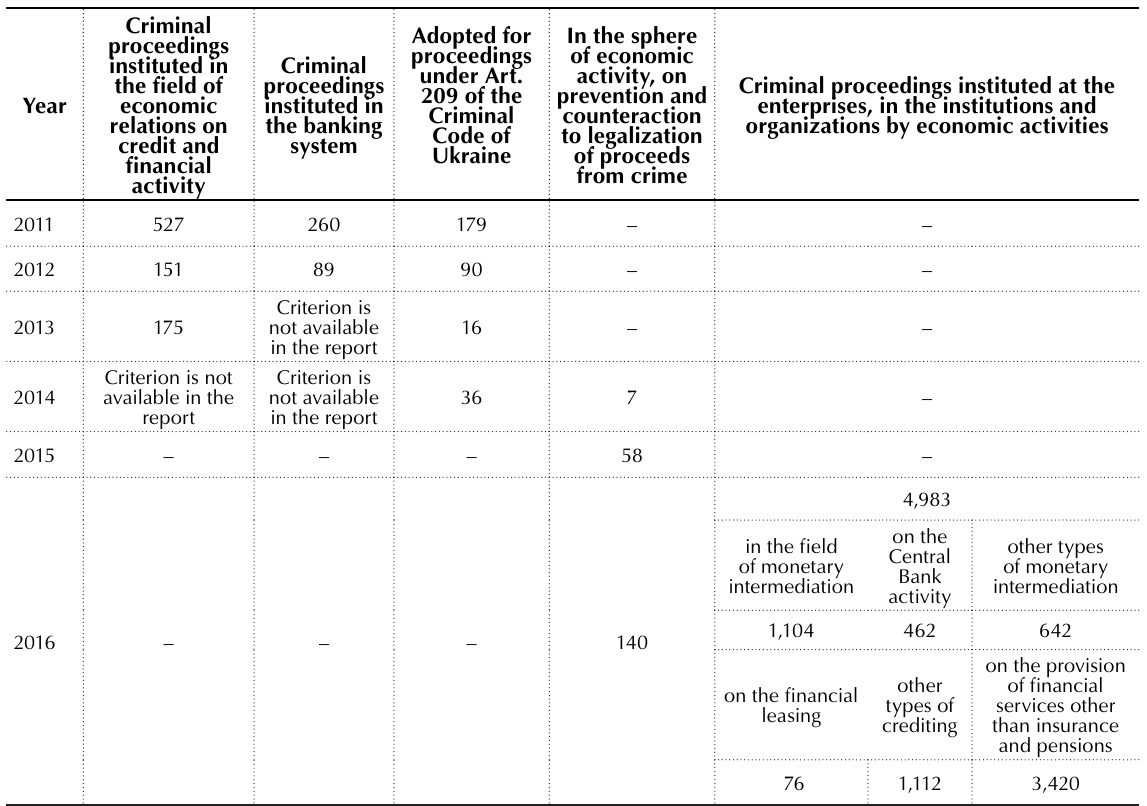
Table 2. Information on criminal offenses in banking for the 2011–2016 period according to the annual reports data of the Prosecutor General’s Office of Ukraine